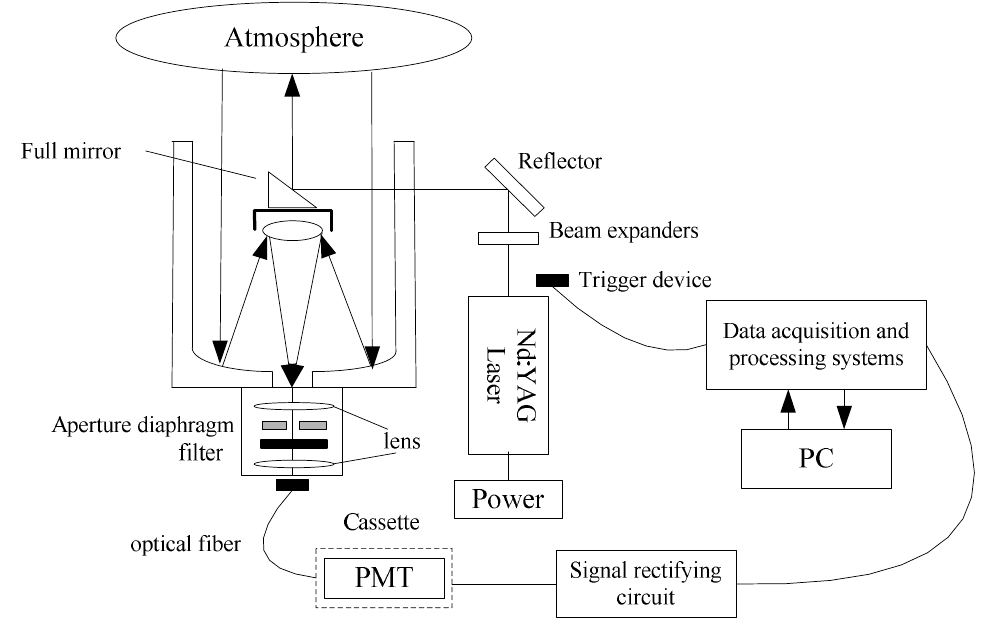
Figure 1. The structure diagram of the Mie lidar system. Table 1. The system parameters of the Mie-scattering lidar.